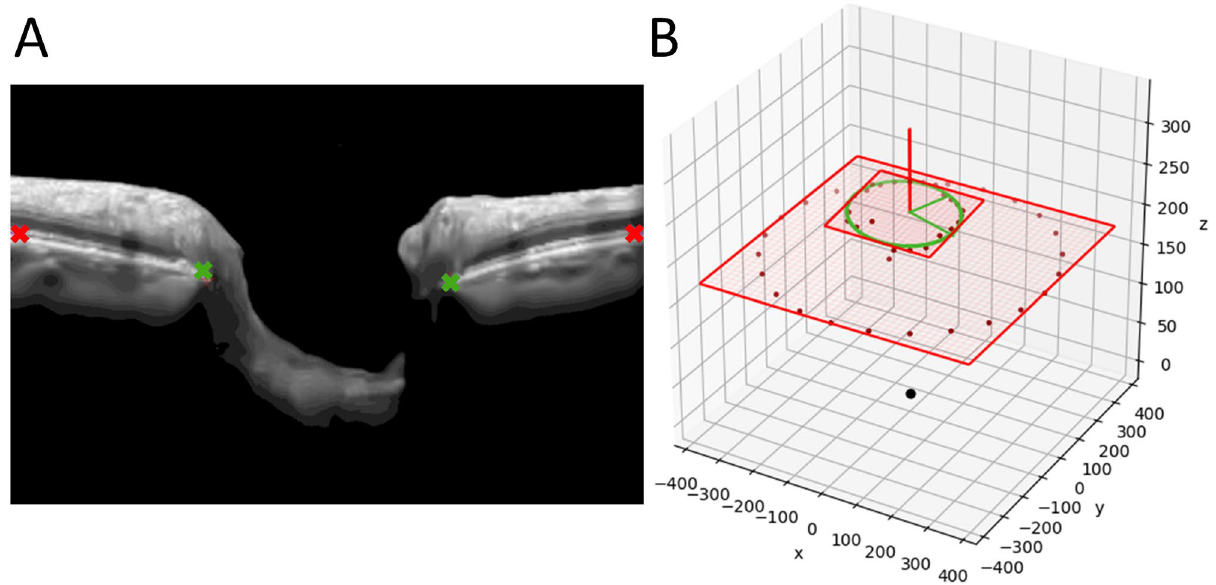
Figure 1. 3D rectangular coordinate space illustrating the BMO fit plane, the BMB fit plane and the corresponding BMB- and BMO points derived from OCT B-scans to calculate tilt and ovality index. ( A ) SALSA-segmented optic disc B-scan demonstrating 2 BMO points (green) and 2 BMB points (red) used to project on the rectangular coordinate space to calculate BMO ovality index, tilt and rotation angle. ( B ) The green ellipse represents the fit BMO ellipse and the smaller red rectangle represents the fit BMO plane. The larger red rectangle represents the fit BMB plane, calculated from the BMB ellipse (red dots inside the larger red rectangle). The red vector from the center of the fit ellipse represents the normal vector to the fit ellipse and helps to illustrate the tilt. The black point represents the origin of the coordinate system. The two green vectors from the center of the fit ellipse are the semi-major and semi-minor axes used to calculate the BMO ovality index calculated as the minor BMO axis divided by the major BMO axis. Abbreviations: BMB, Bruch’s membrane boundary; BMO, Bruch’s membrane opening; SALSA, San Diego Automated Layer Segmentation Algorithm.